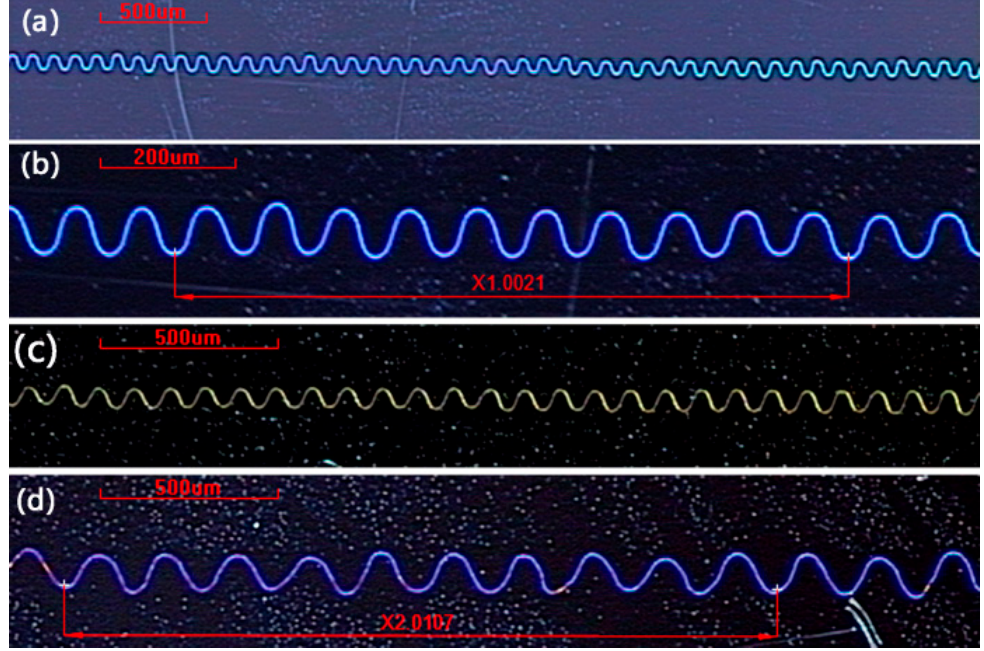
Figure 2. Optical images of the morphology of the serpentine microstructure with different amplitude and frequency of AC voltage applied as well as different substrate velocities: ( a , b ) 240 V, 50 Hz, 5 mm/s; ( c ) 180 V, 50 Hz, 5 mm/s; ( d ) 300 V, 60 Hz, 12 mm/s. The solution concentration of (a–c) is 8% and (d) is 6%. All of them were deposited in the following conditions: DC voltage 1.3 kV, auxiliary electrode-to-collector distance 7 mm, nozzle-to-substrate distance 5 mm.